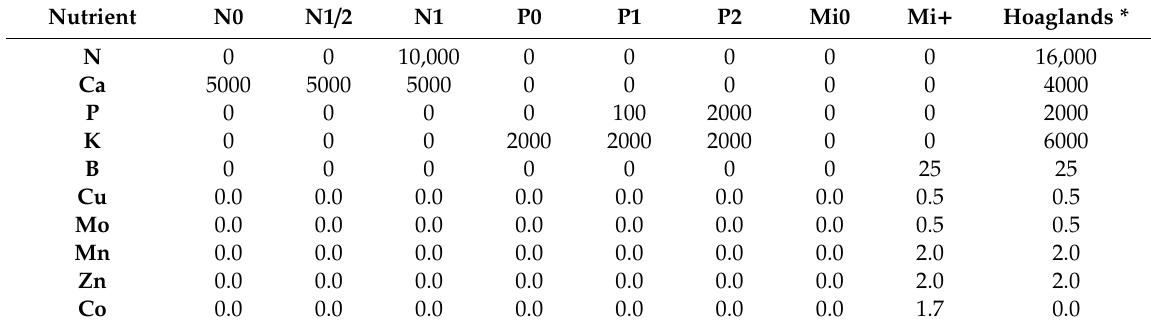
Table A1. Macro- and micro-nutrients and their concentrations ( µ M) in each 150 mL watering solution.